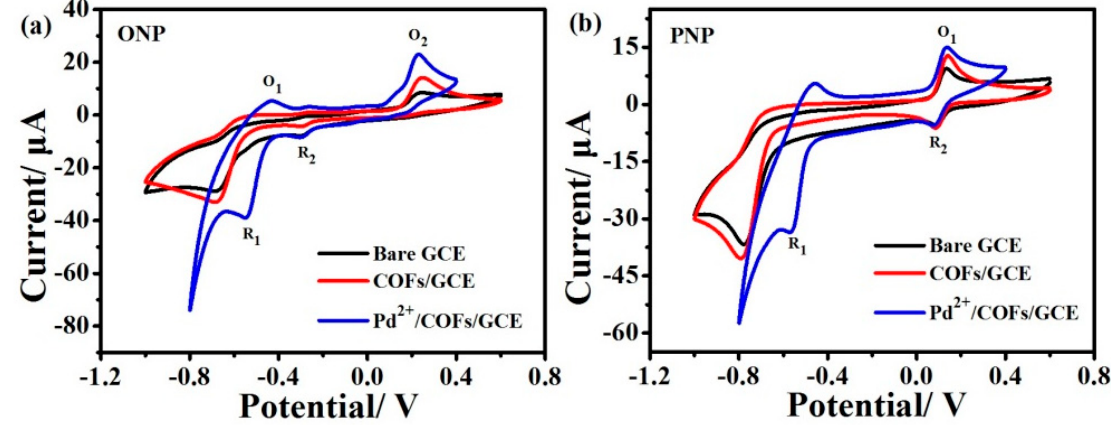
Figure 6. CVs of bare GCE, COFs/GCE, Pd 2+ /COFs/GCE in the presence of 500 µ M nitrophenol (( a ): ONP, ( b ): PNP) at a scan rate of 50 mV s − 1 in 0.1 M PBS (pH = 7.0).